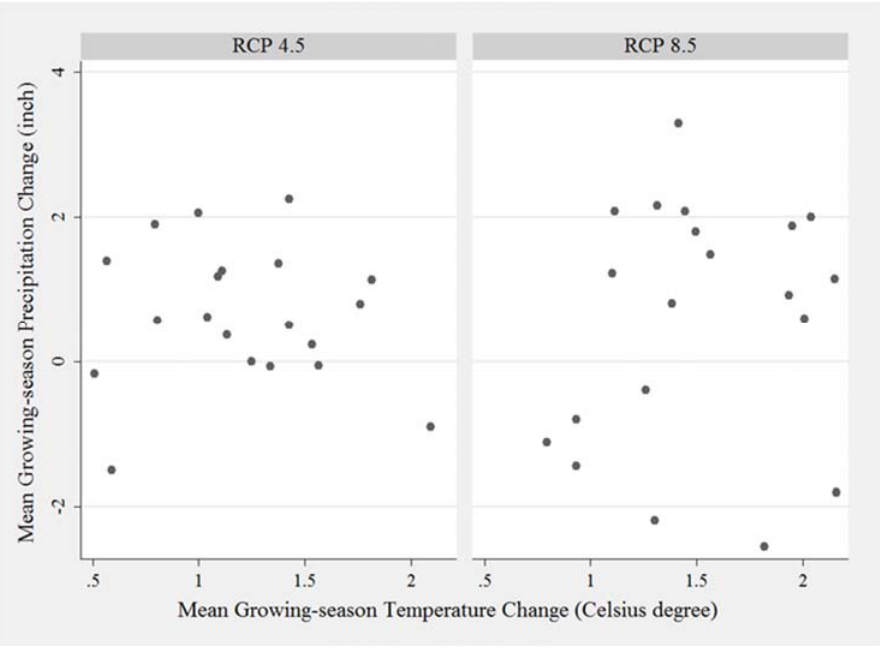
Figure 1. Projected changes in mean growing season total precipitation and average temperature by 2050 with a baseline period from 1982–2011. Each dot represents a projection from a particular CMIP5 climate model.